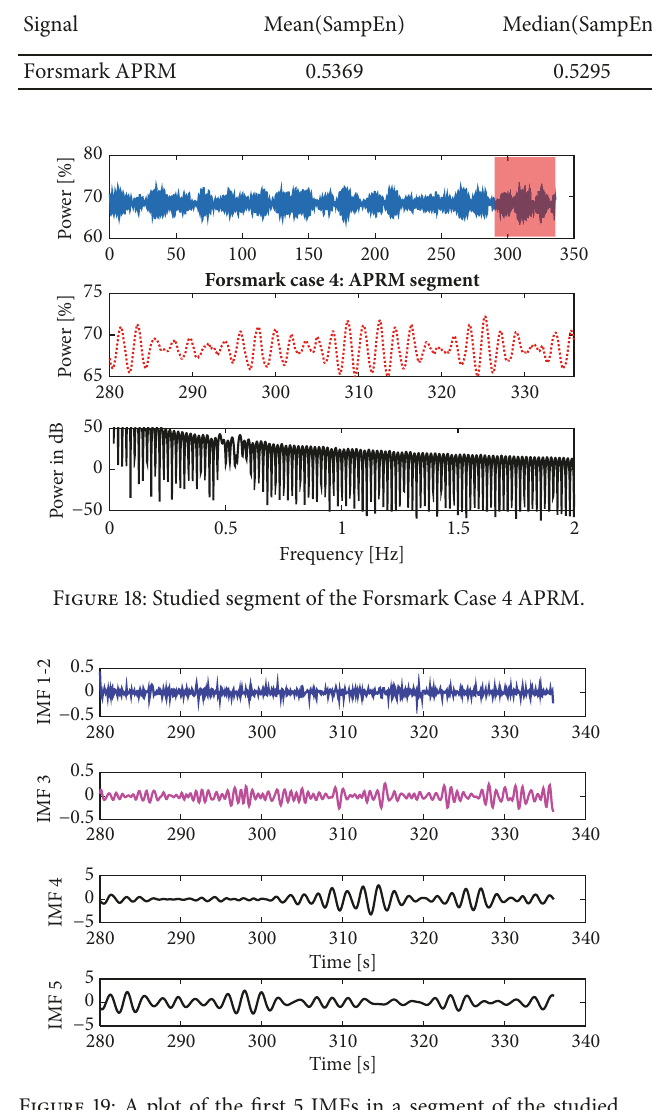
Figure 19: A plot of the first 5 IMFs in a segment of the studied Forsmark APRM.